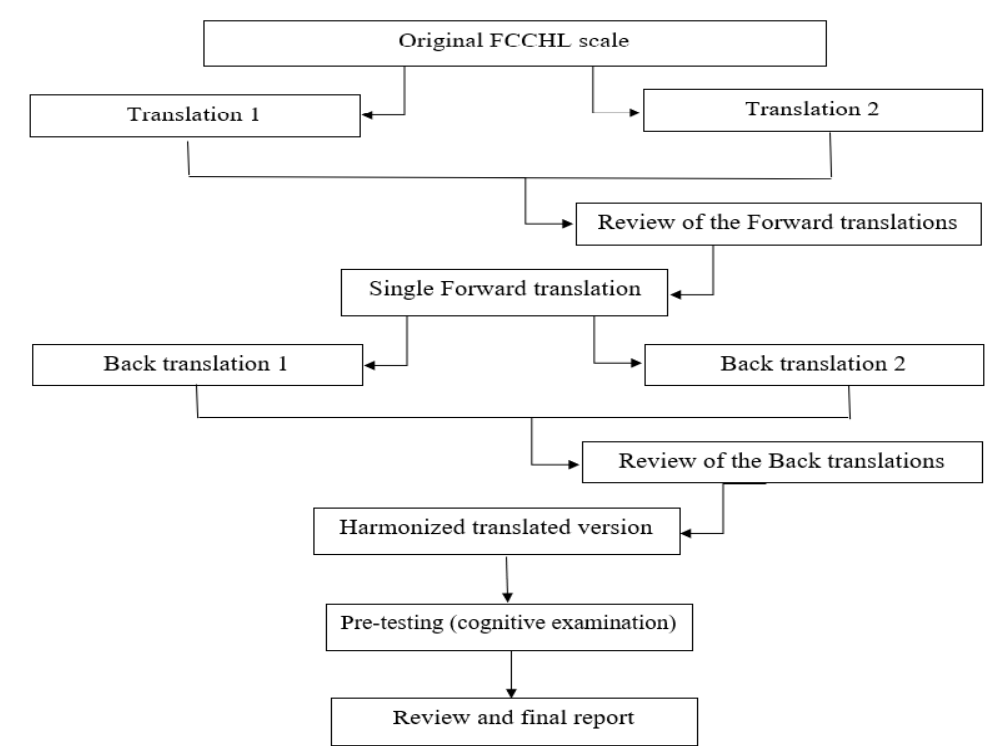
Figure 1. Translation and cross-cultural adaptation steps for FCCHL instrument